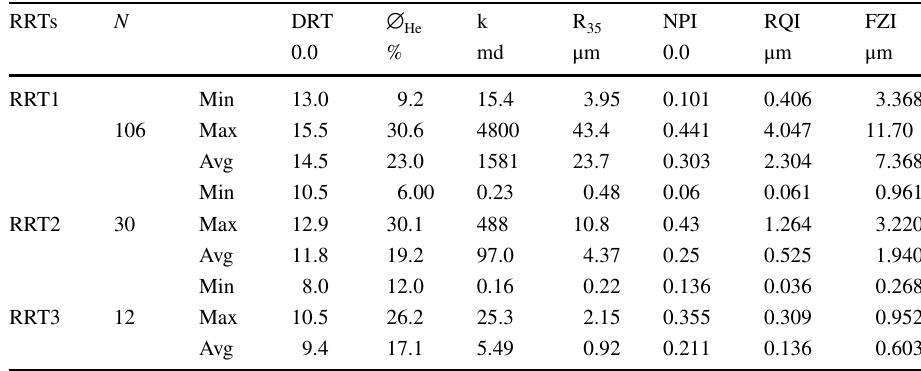
Table 2 Porosity, permeability, and reservoir quality parameters of the cored Albian intervals in the SWM Oil